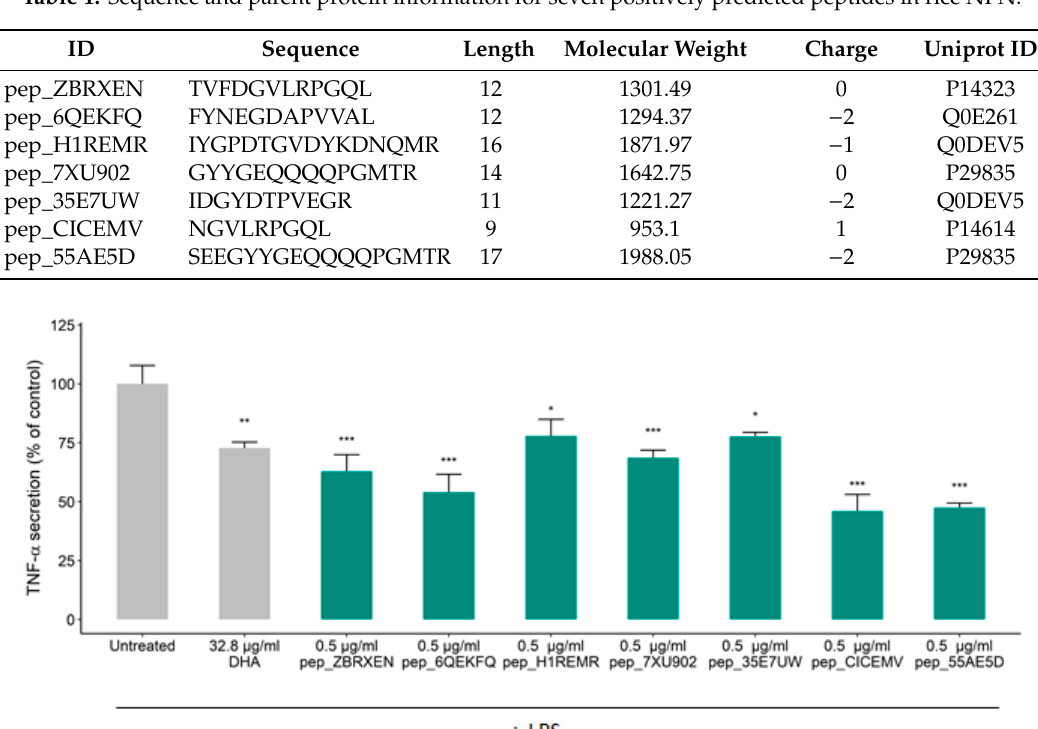
Table 1. Sequence and parent protein information for seven positively predicted peptides in rice NPN.